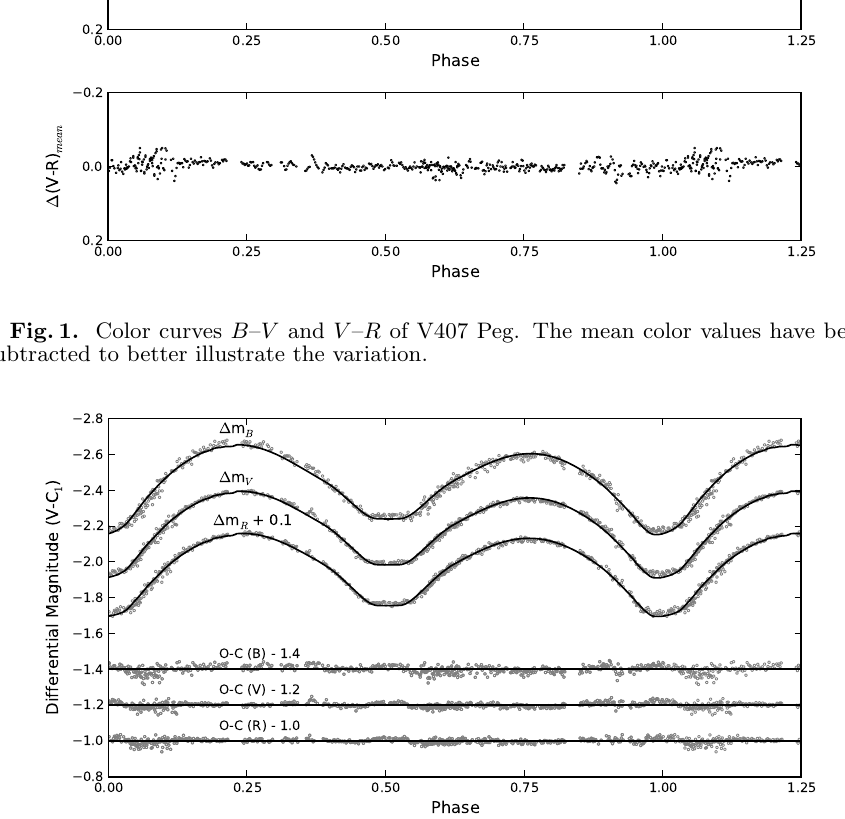
Fig. 2. Observational (circles) and synthetic (solid lines) BVR light curves for V407 Peg. Residuals from the theoretical fits are at the bottom of the figure. Arbi- trary shifts for better viewing are indicated in the figure where